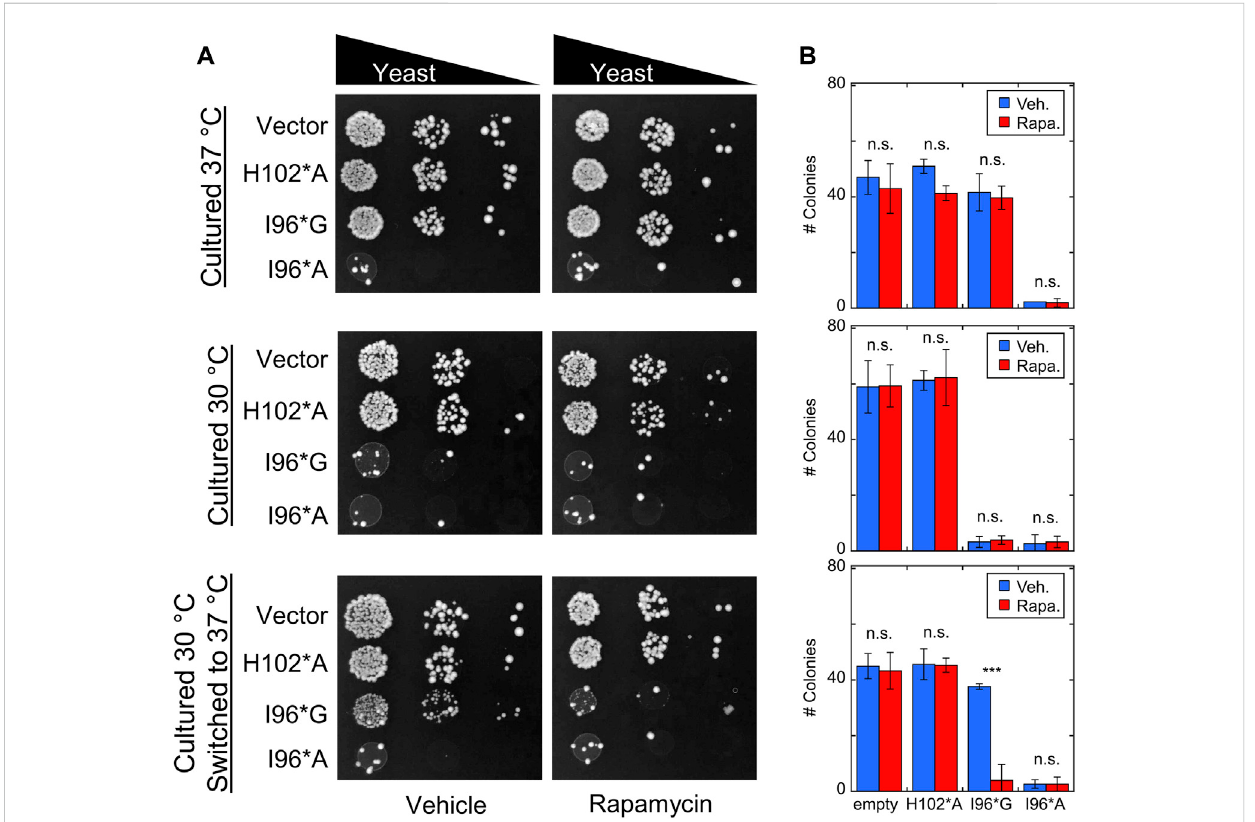
FIGURE 6 Bn-AFF demonstrates rapamycin-dependent toxicity in yeast. (A) Yeast cells were transformed with the indicated Bn-AFF constructs, spotted onto plates at 10, 100, and 1000-fold dilutions, and cultured at 30 ° C for 3 d (top row), 37 ° C for 3 d (middle row), or 30 ° C for 2 d then 37 ° C for 1 d (bottom row). I96*A was toxic at all three temperature conditions, whereas I96*G was toxic only at 30 ° C. I96*G exhibited rapamycin-dependent toxicity in cells that were shifted from 30 ° C to 37 ° C. (B) Rapamycin treatment resulted in signi fi cantly fewer colonies of I96*G cells grown at 30 ° C and shifted to 37 °